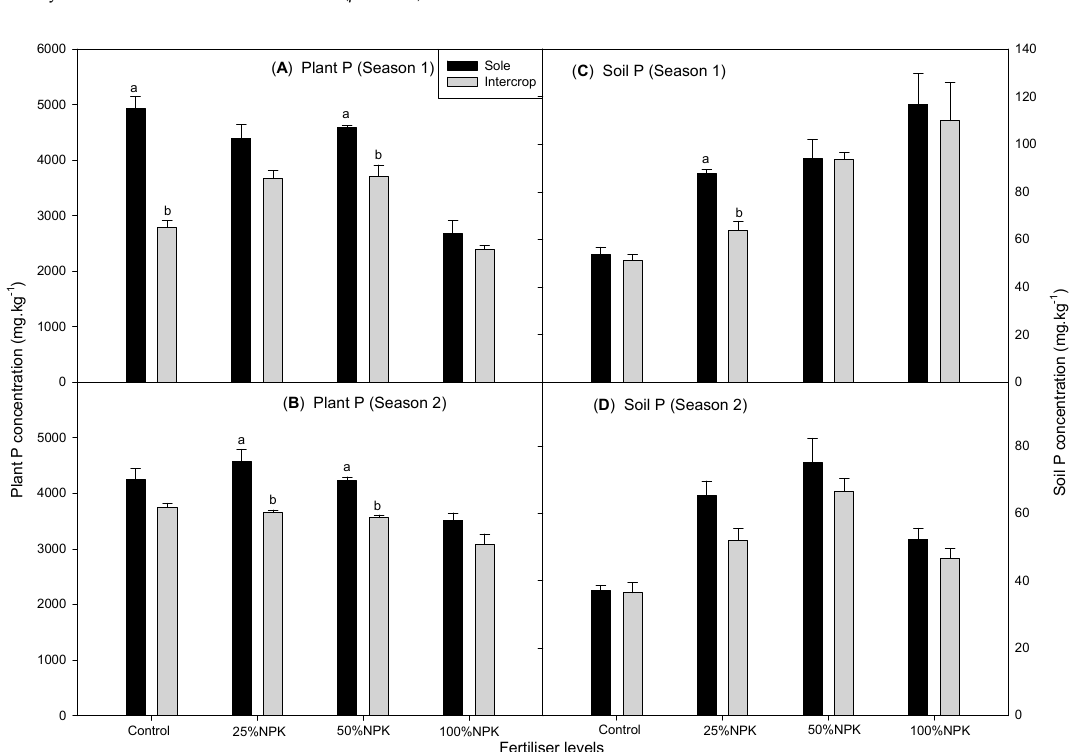
Mean ± SE (n = 4) values in each column followed by different letters indicate significant differences between treatments. Numerical values following different letters have been superscripted to compare means of each cropping system at different fertiliser levels ( p ≤ 0.05).